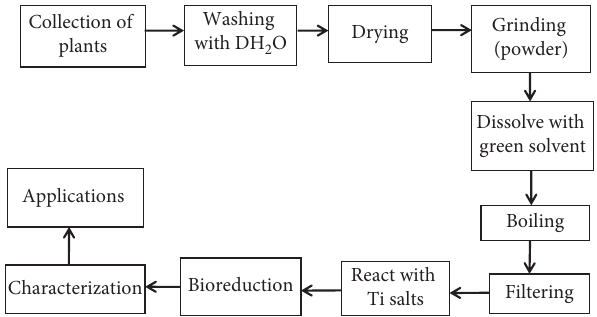
Figure 4: Some selected types of plants used as a template for TiO